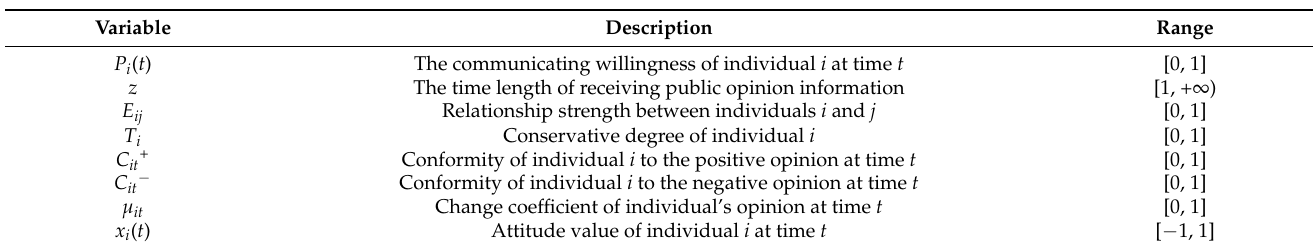
Table 2. Related